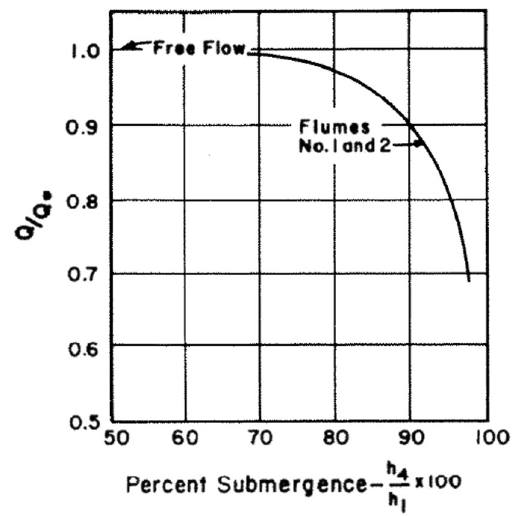
Fig. 3 Flow correction factor for different immersion conditions in trapezoidal flume. Q is the actual discharge and Q 0 is the observa- tional discharge. h 4 = water depth at the outlet of the flume (Fig. 2). (Robinson 1966, 1968; Larsen